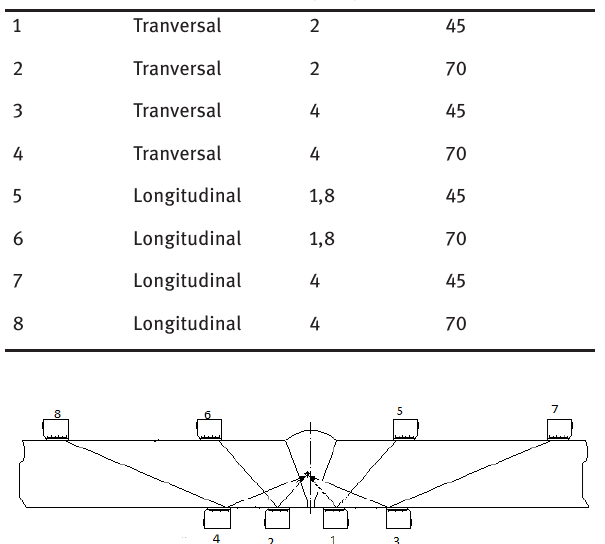
Figure 1: The probe positions in the